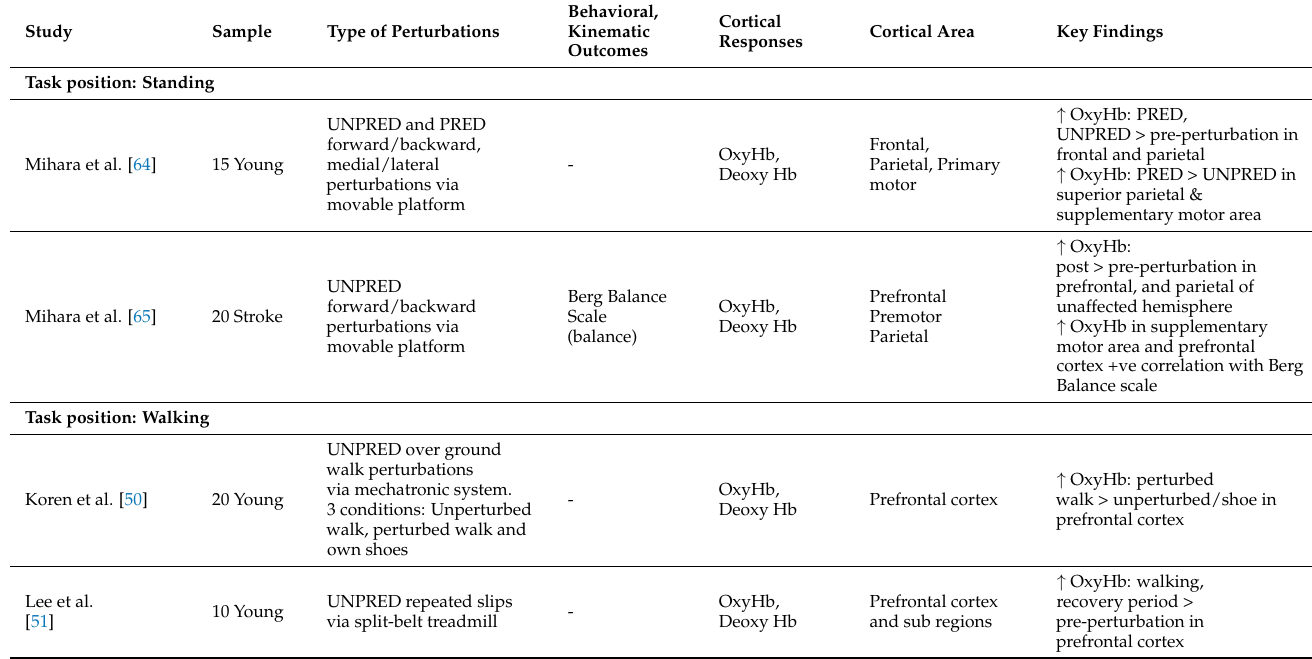
Table 4. Changes in oxygenated and deoxygenated hemoglobin (Hb) levels recorded via functional near-infrared spectroscopy (fNIRS) in response to novel and repeated unpredictable (UNPRED) mechanical perturbations (RQ1).